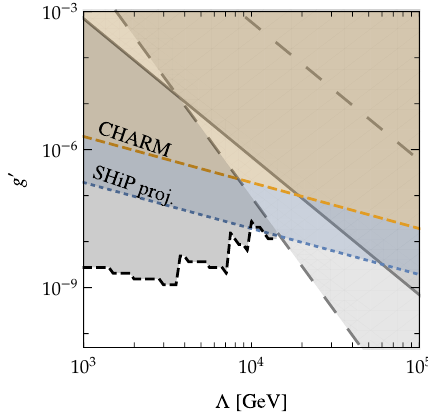
Figure 12 . Zoom in the left-up corner of (cid:12)gure 8 where we show the region where CHARM ( m (cid:30) 2 [0 : 20 GeV ; 0 : 35 GeV]) and SHiP ( m (cid:30) 2 [0 : 20 GeV ; 4 GeV]) can probe part of the f 0 {(cid:3) b parameter space. Such region is constrained by the conditions to obtain a successful relaxation through particle production as indicated by the gray